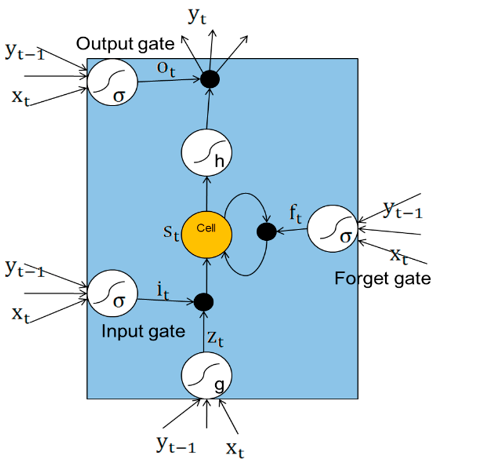
Figure 5. LSTM model structure diagram.